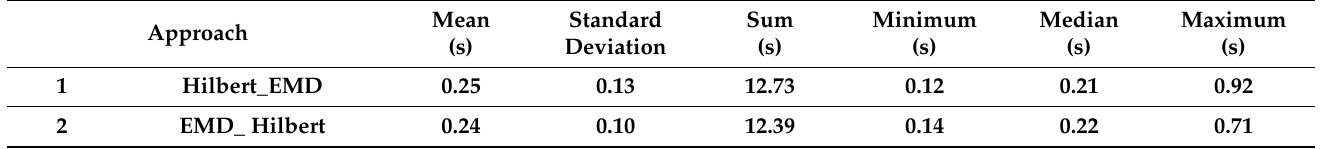
Figure 17. Comparison of CPU times by Matlab using different approaches. Table 3. Comparison of CPU times by Matlab using different